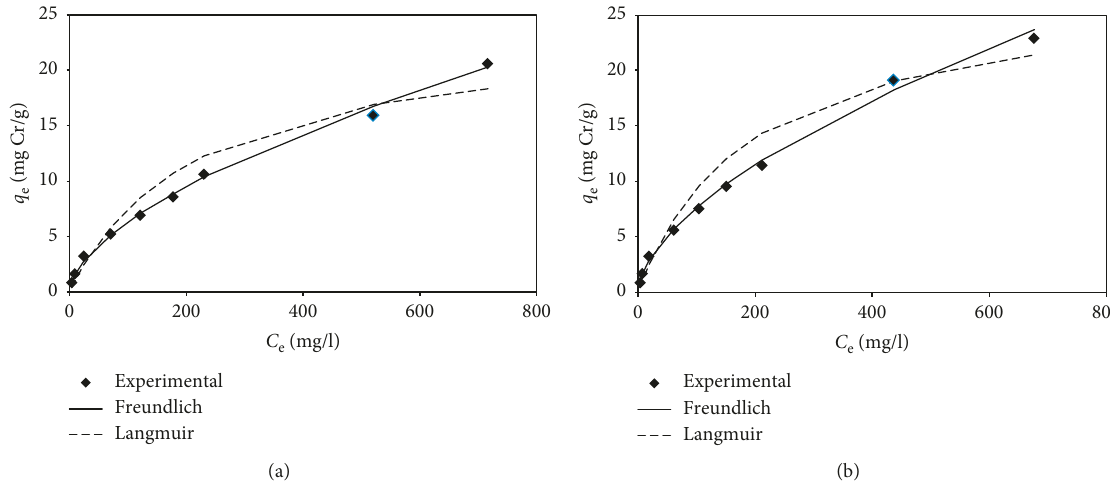
Figure 6: Adsorption of chromium(VI) on PAC at 298K (a) and 323K(b). Solid line: fitting to the Freundlich isotherm; dashed line: fitting to the Langmuir isotherm.